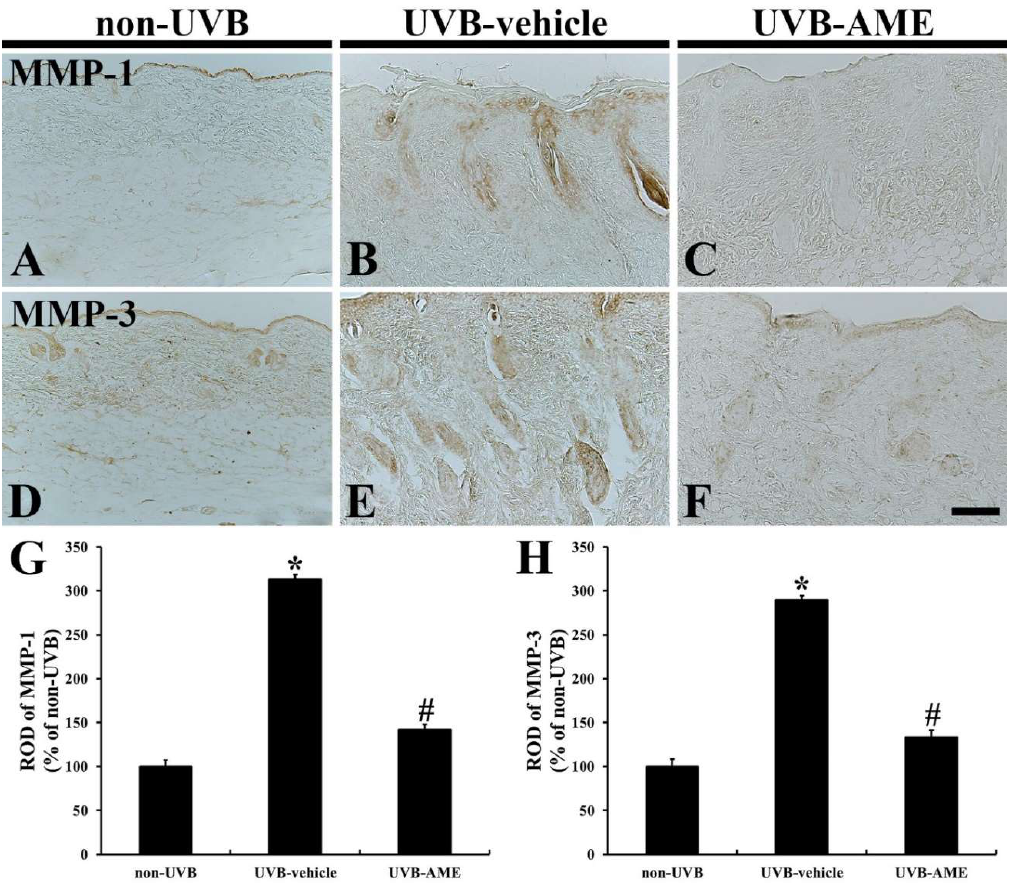
Figure 6. ( A – F ) Immunohistochemistry for matrix metalloproteinase-1 (MMP-1) ( A – C ) and 3 ( D – F ) in the dorsal skin of the non-UVB (A and D), UVB-vehicle (B and E) and UVB-AME (C and F) at 7 days after UVB irradiation. In the UVB-vehicle group, MMP-1 and 3 immunoreactivity is significantly enhanced in the dermis. However, in the UVB-AME group, MMP-1 and 3 immunoreactivity is significantly weakened compared to that in the UVB-vehicle group. Scale bar = 100 μm. ( G and H ) RODs of MMP-1 ( G ) and 3 immunoreactivity in the dorsal skin of each group at 7 days after UVB irradiation. Bars indicate the means ± SEM ( n = 10 in each group, * p < 0.05 vs. non-UVE group, # p < 0.05 vs. UVB-vehicle group).